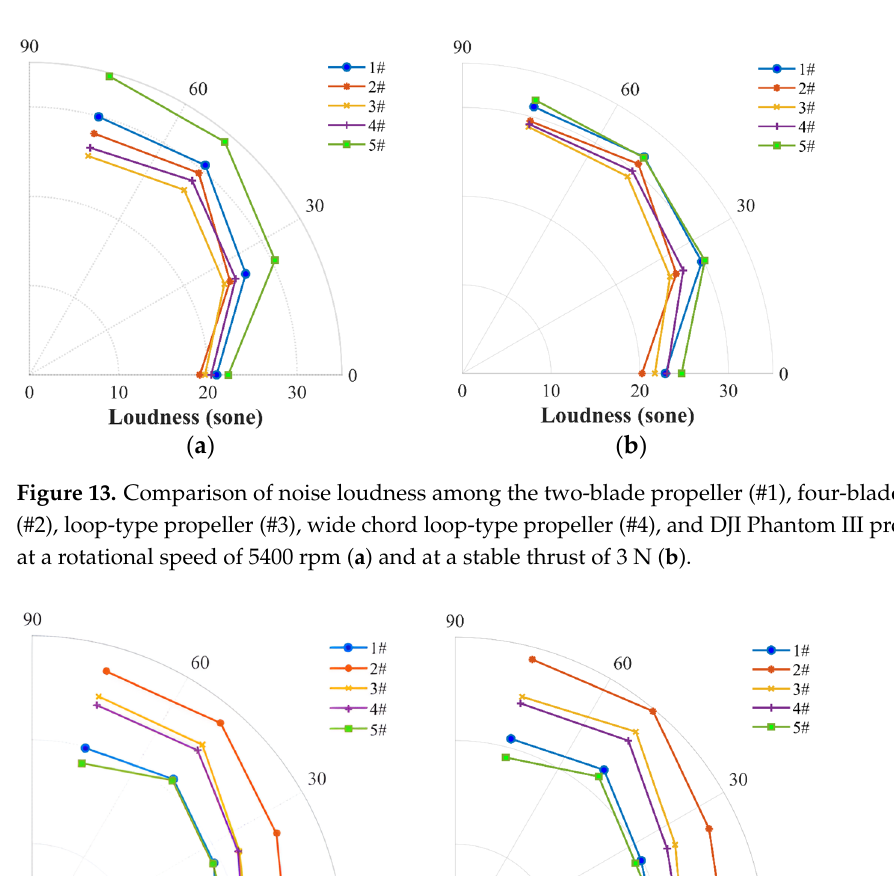
Figure 13. Comparison of noise loudness among the two-blade propeller (#1), four-blade propeller (#2), loop-type propeller (#3), wide chord loop-type propeller (#4), and DJI Phantom III propeller (#5) at a rotational speed of 5400 rpm ( a ) and at a stable thrust of 3 N ( b ).